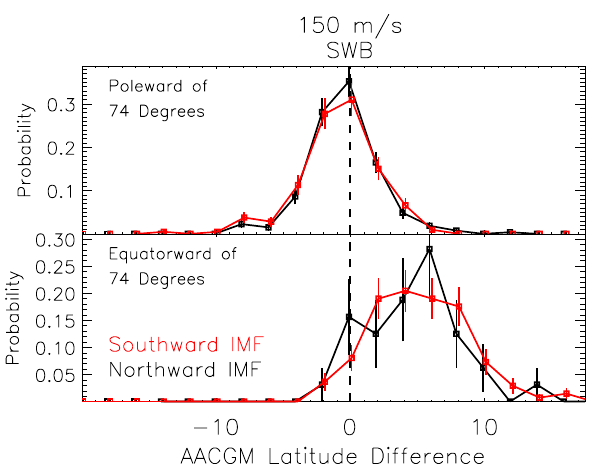
Fig. 6. Probability distributions of latitude differences between the DMSP doc boundary and the 150m/s threshold SWB for the com- bined Goose Bay and Finland SuperDARN radars in the 12:00– 18:00 MLT region. The upper panel represents the results from comparisons using SWBs located poleward of 74 ◦ , whereas the lower panel represents the results from comparisons using SWBs located equatorward of 74 ◦ . The black distributions represent the results measured during intervals of prevailing northward IMF con- ditions, whereas the red distributions represent the results measured during intervals of prevailing southward IMF